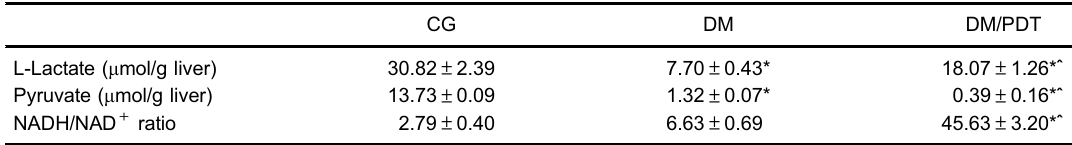
Data reported as means ± SD, n=5/group. CG: control animals without light irradiation; DM: type 1 diabetic animals without